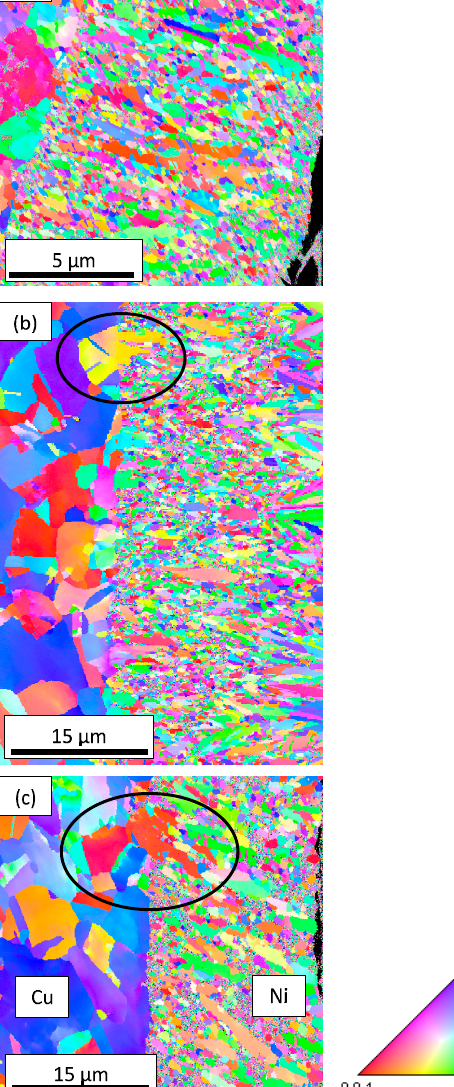
Figure 10. Electron backscatter diffraction (EBSD) orientation color maps of the electrodeposited Ni on copper ( a ) without and with the addition of TiO 2 , ( b ) 5 g/L of TiO 2 , ( c ) 10 g/L of TiO 2 . (The crystallographic direction is perpendicular to the observation plane A1-A2).